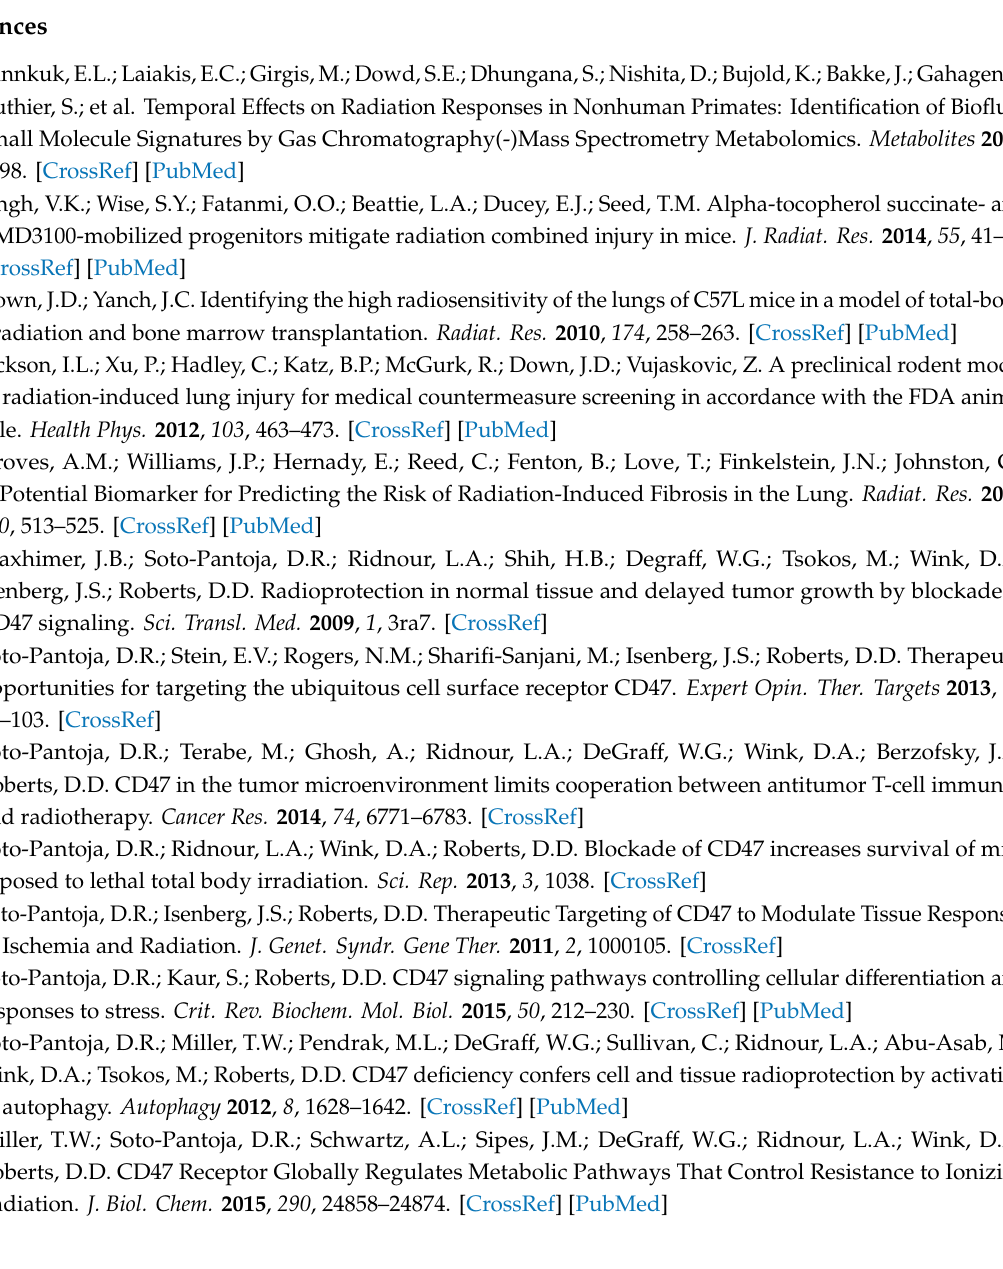
Figure S1: Random forest analysis of WT and cd47 null mice, Figure S2: Metabolites regulated in WT and cd47 deficient T cells after ionizing radiation, Figure S3: Supporting metabolites of antioxidant and lipid